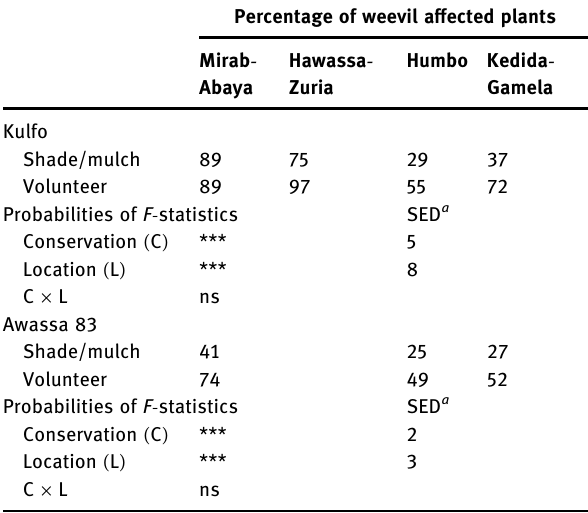
Table 3: E ff ect of conservation method and location on percentage of weevil - infested plants in multiplication